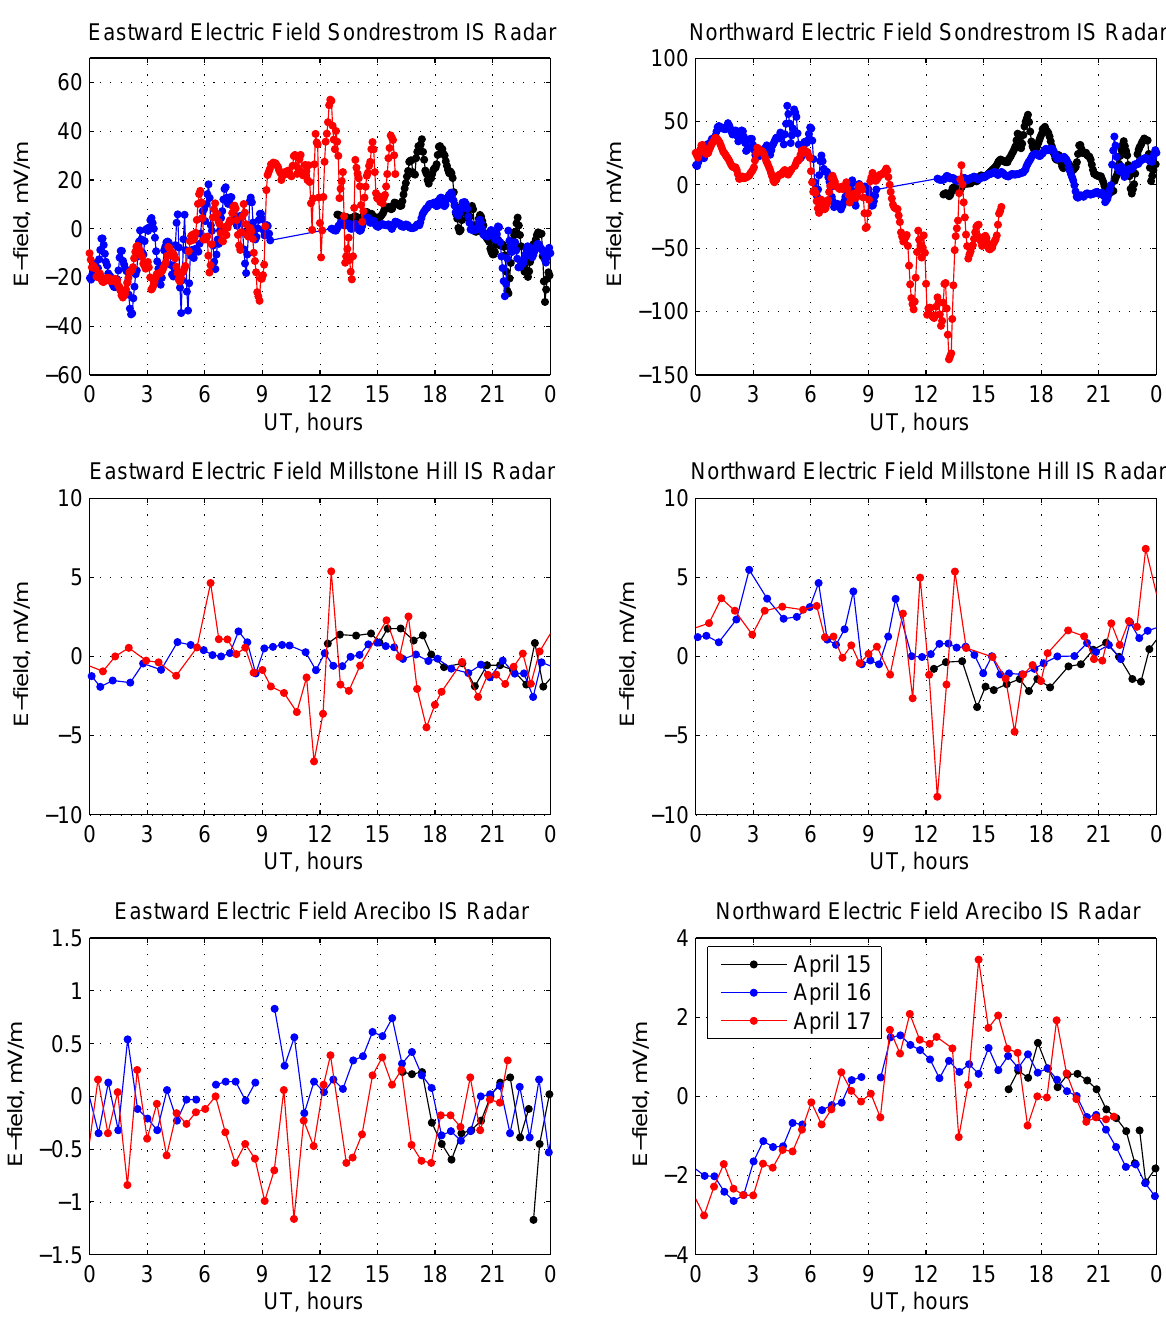
Fig. 13. Eastward (left panel) and northward (right panel components of local electric field observed over Sondrestrom (top), Millstone Hill (middle) and Arecibo